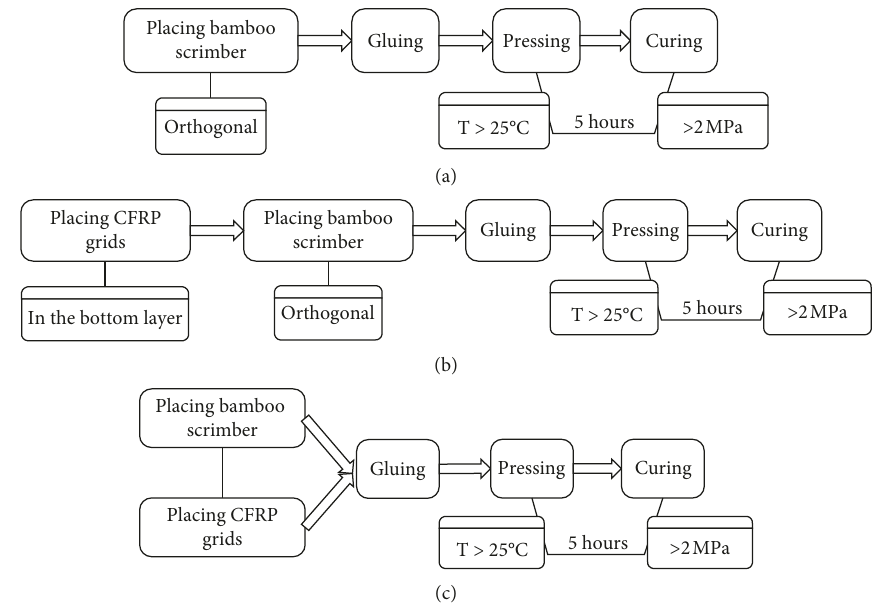
Figure 11: Fabrication processes of slab specimens. (a) One-way CLB slab. (b) One-way CLB slab strengthened with CFRP grids: manufacturing process I. (c) One-way CLB slab strengthened with CFRP grids: manufacturing process M.